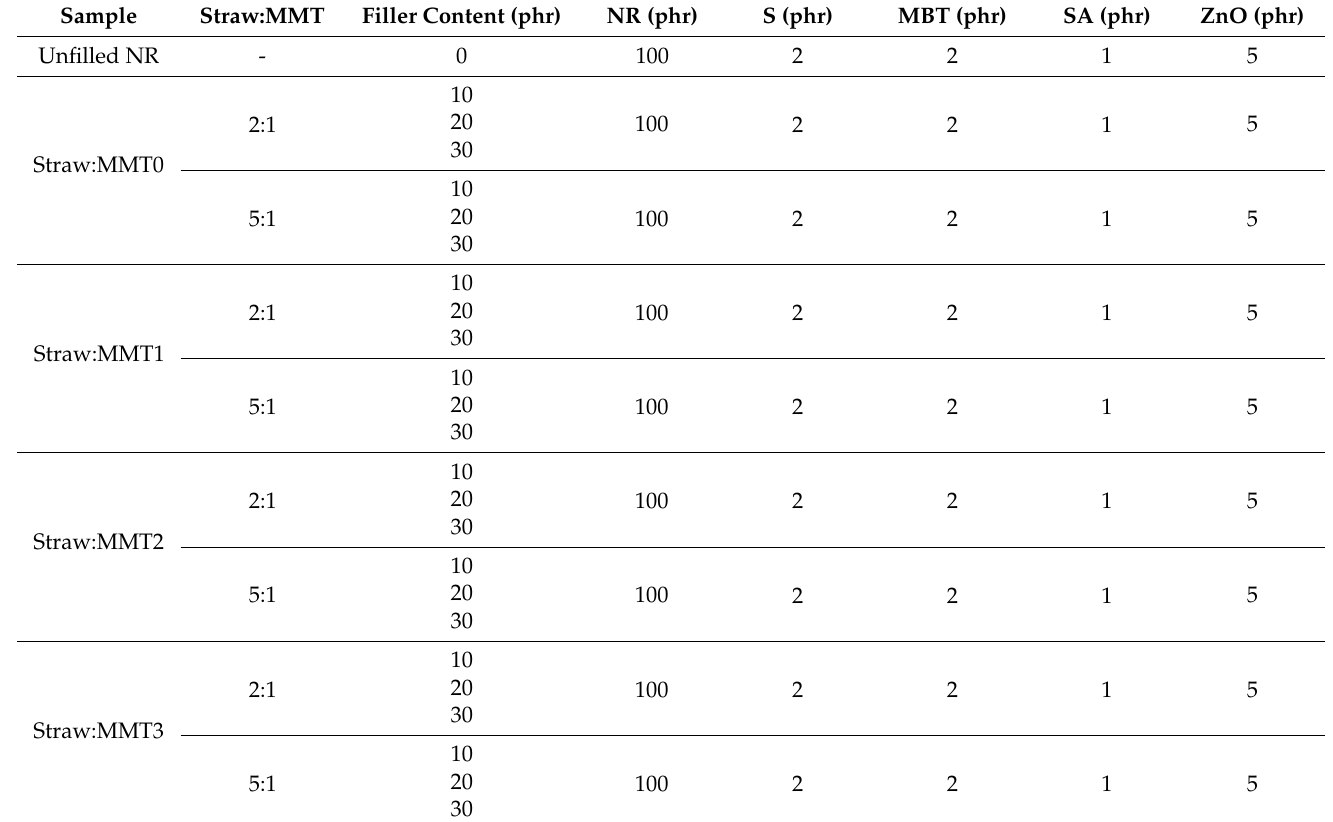
Table 1. Composition of elastomer